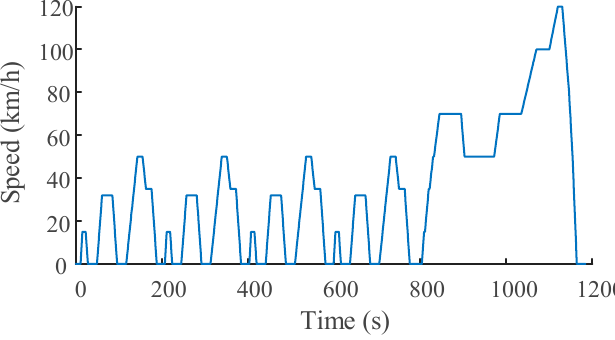
Figure 10. New European Driving Cycles (NEDC) condition.